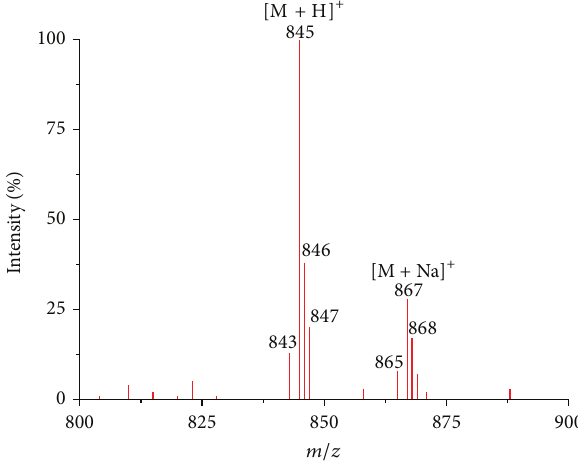
Figure 9: Mass spectrum ( I ) + GSH (as in experiment, shown in Figure 8) after 24 h from the start of the reaction: (ESI, +4.5kV). ( I ) is the complex [ Fe 2 ( SC 5 H 11 NO 2 ) 2 ( NO ) 4 ] SO 4 ⋅5 H 2 O. M is the cation of ( II